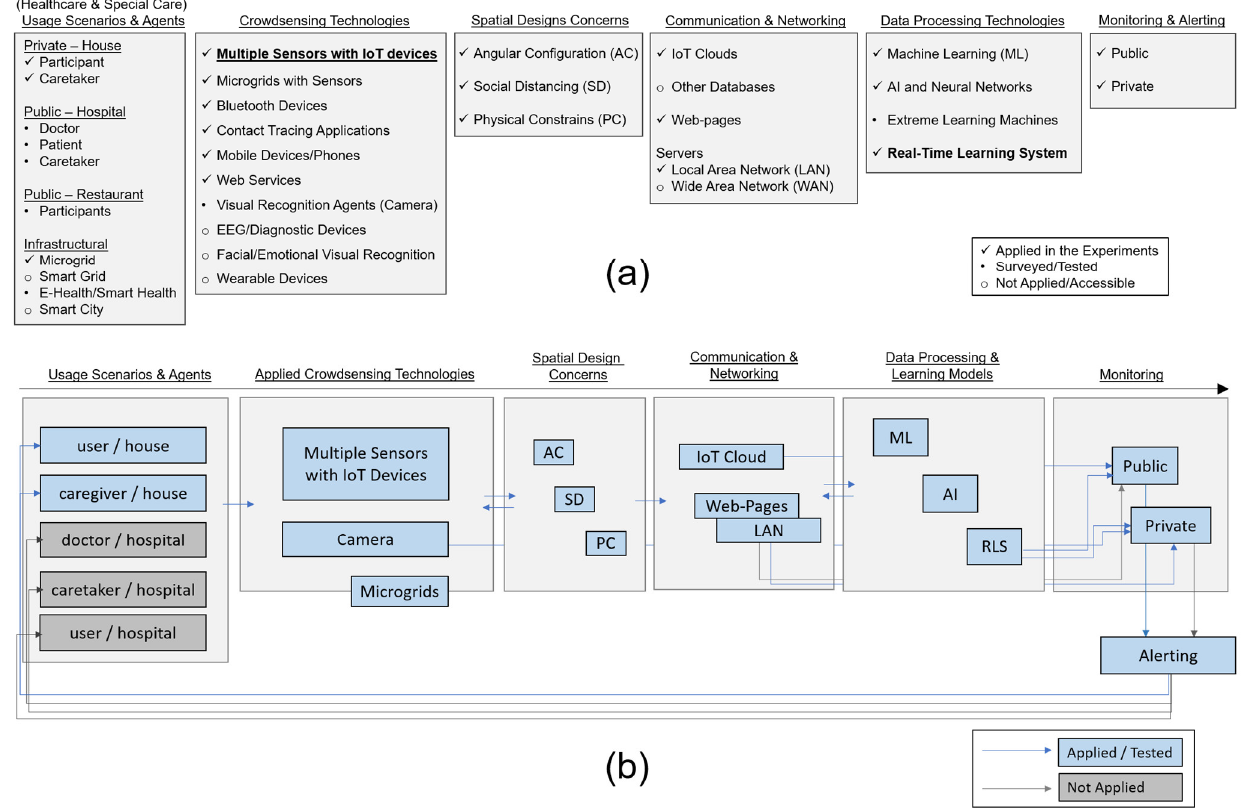
Figure 1. ( a ) Surveyed technologies and spatial usage scenarios for ( b ) the applied methodology and the scope of the research.